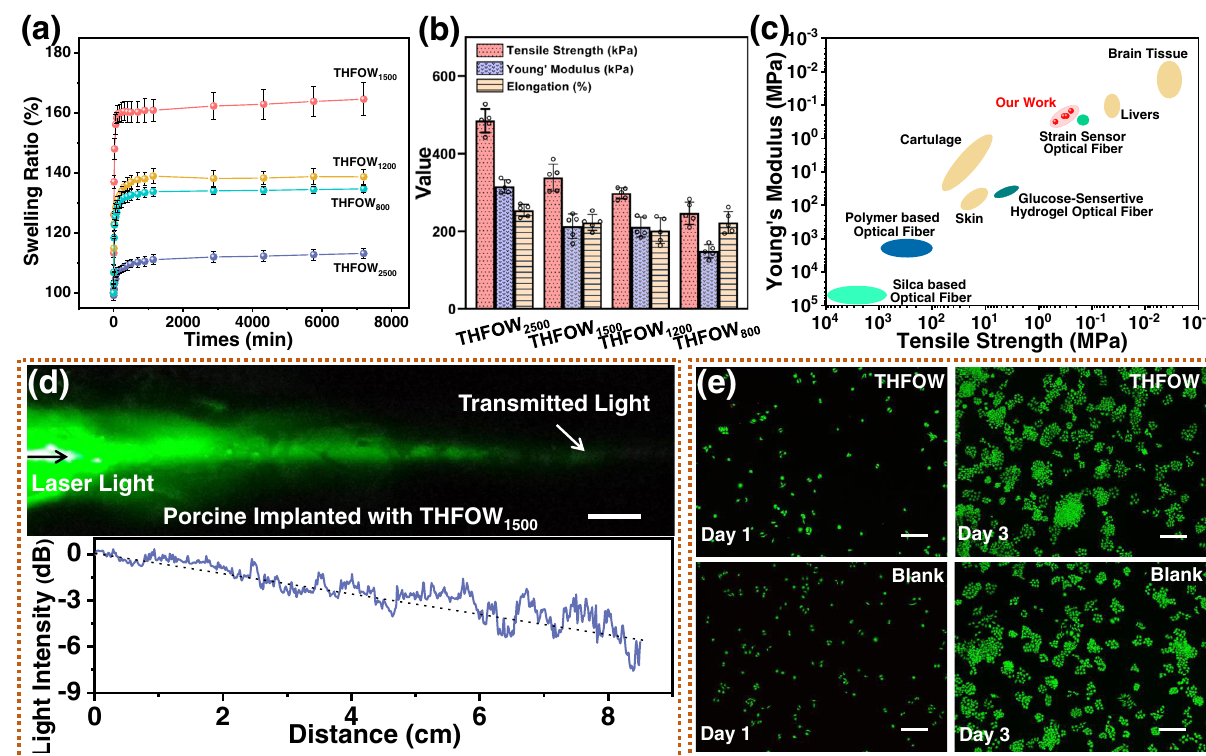
Fig. 5 | Compatibility of the THFOW with organisms. a Swelling behavior ( n =3 independent experiments) and ( b ) mechanical properties ( n =5 independent experiments) of the fabricated THFOWs, data in ( a ) and ( b ) were presented as mean±SD; ( c ) Comparison of mechanical properties among the THFOW, tissues and otherlight-guide fi bers;( d )Laserlight ( λ =515nm)propagationwithinporcine